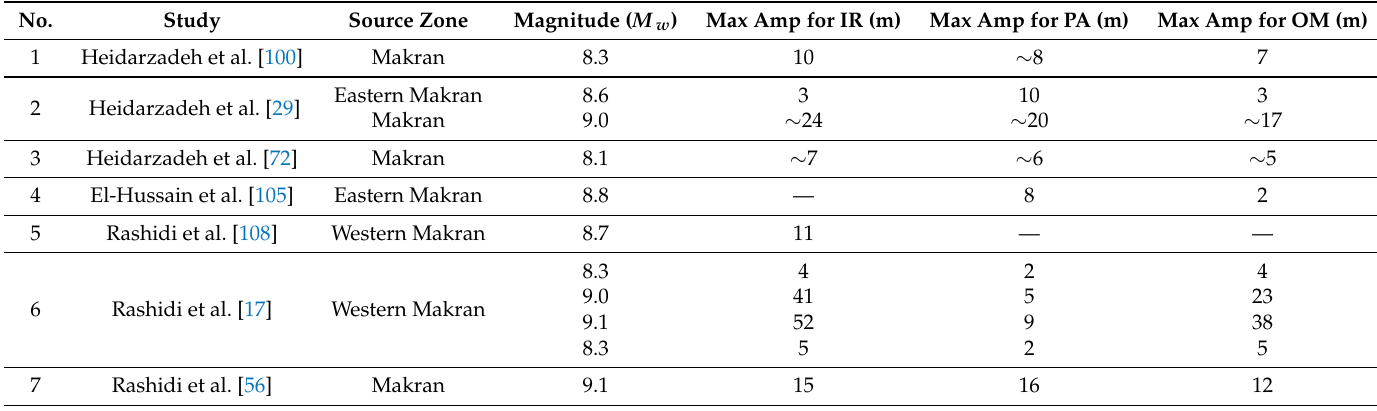
Table 1. Comparison between computed maximum values of coastal amplitude along the coastlines of Iran (IR), Pakistan (PA) and Oman (OM) from different DTHA studies.